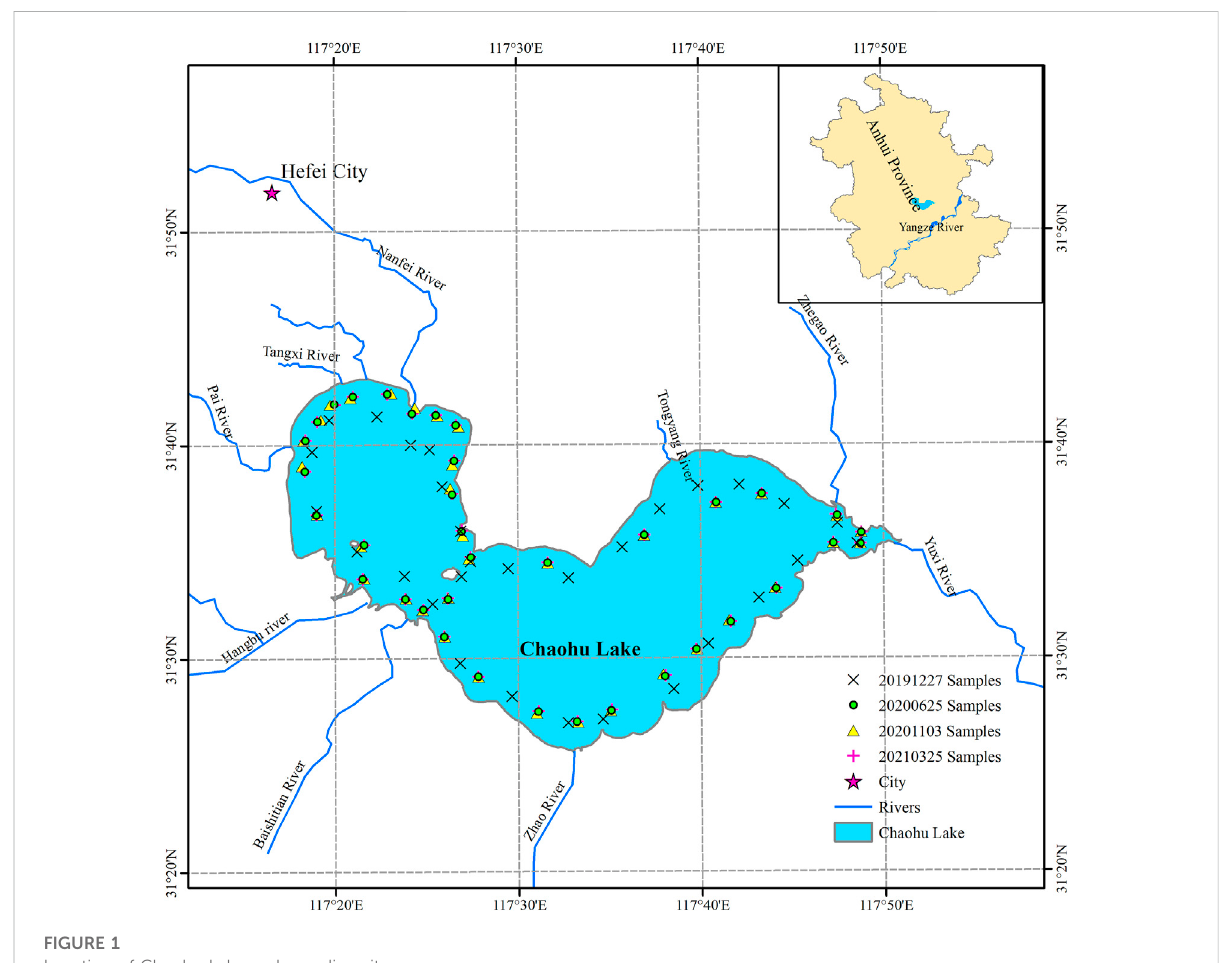
FIGURE 1 Location of Chaohu Lake and sampling